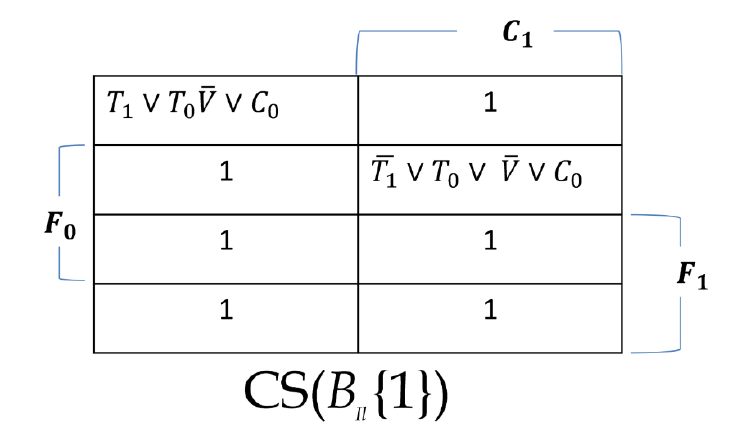
Fig. 12. A variable-entered Karnaugh map for the complete sum of 𝑩 omitted, while don’t-care entries are asserted and disjuncted with the originally asserted entries in